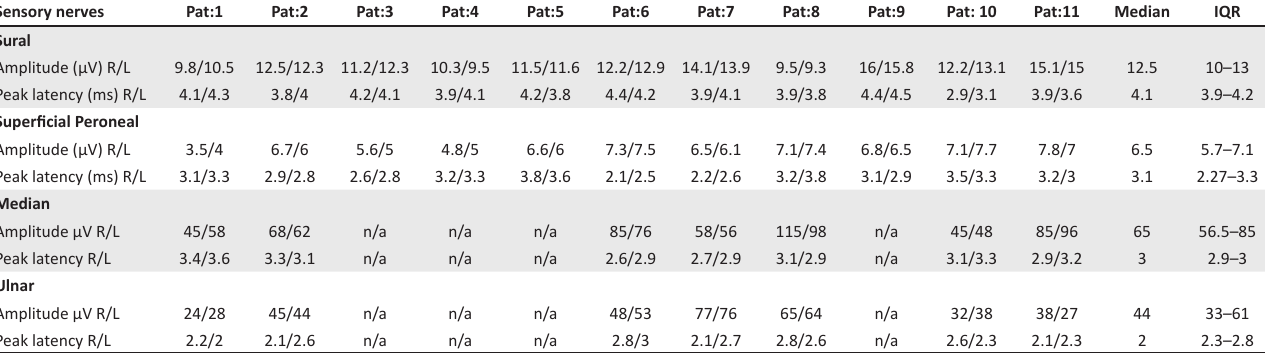
TABLE 3: Electrophysiological findings in patients with motor lumbosacral radiculopathy in HIV-infected patients: Sensory studies. Sensory